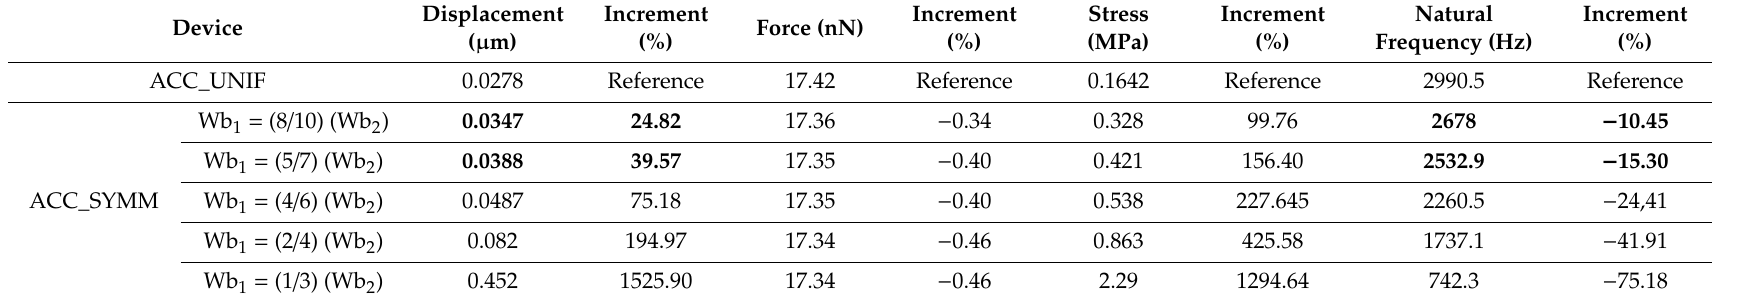
Table 13. Comparison of performance parameters varying the width (W b1 ) of device.